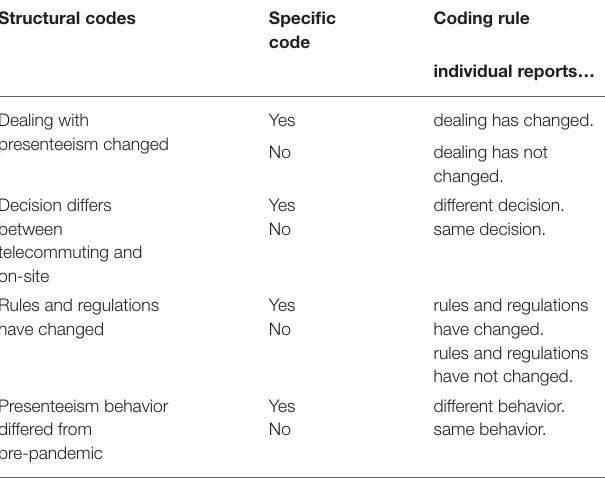
TABLE 2 | Structural codes, specific categories, and coding rules for the first cycle inductive coding. Structural